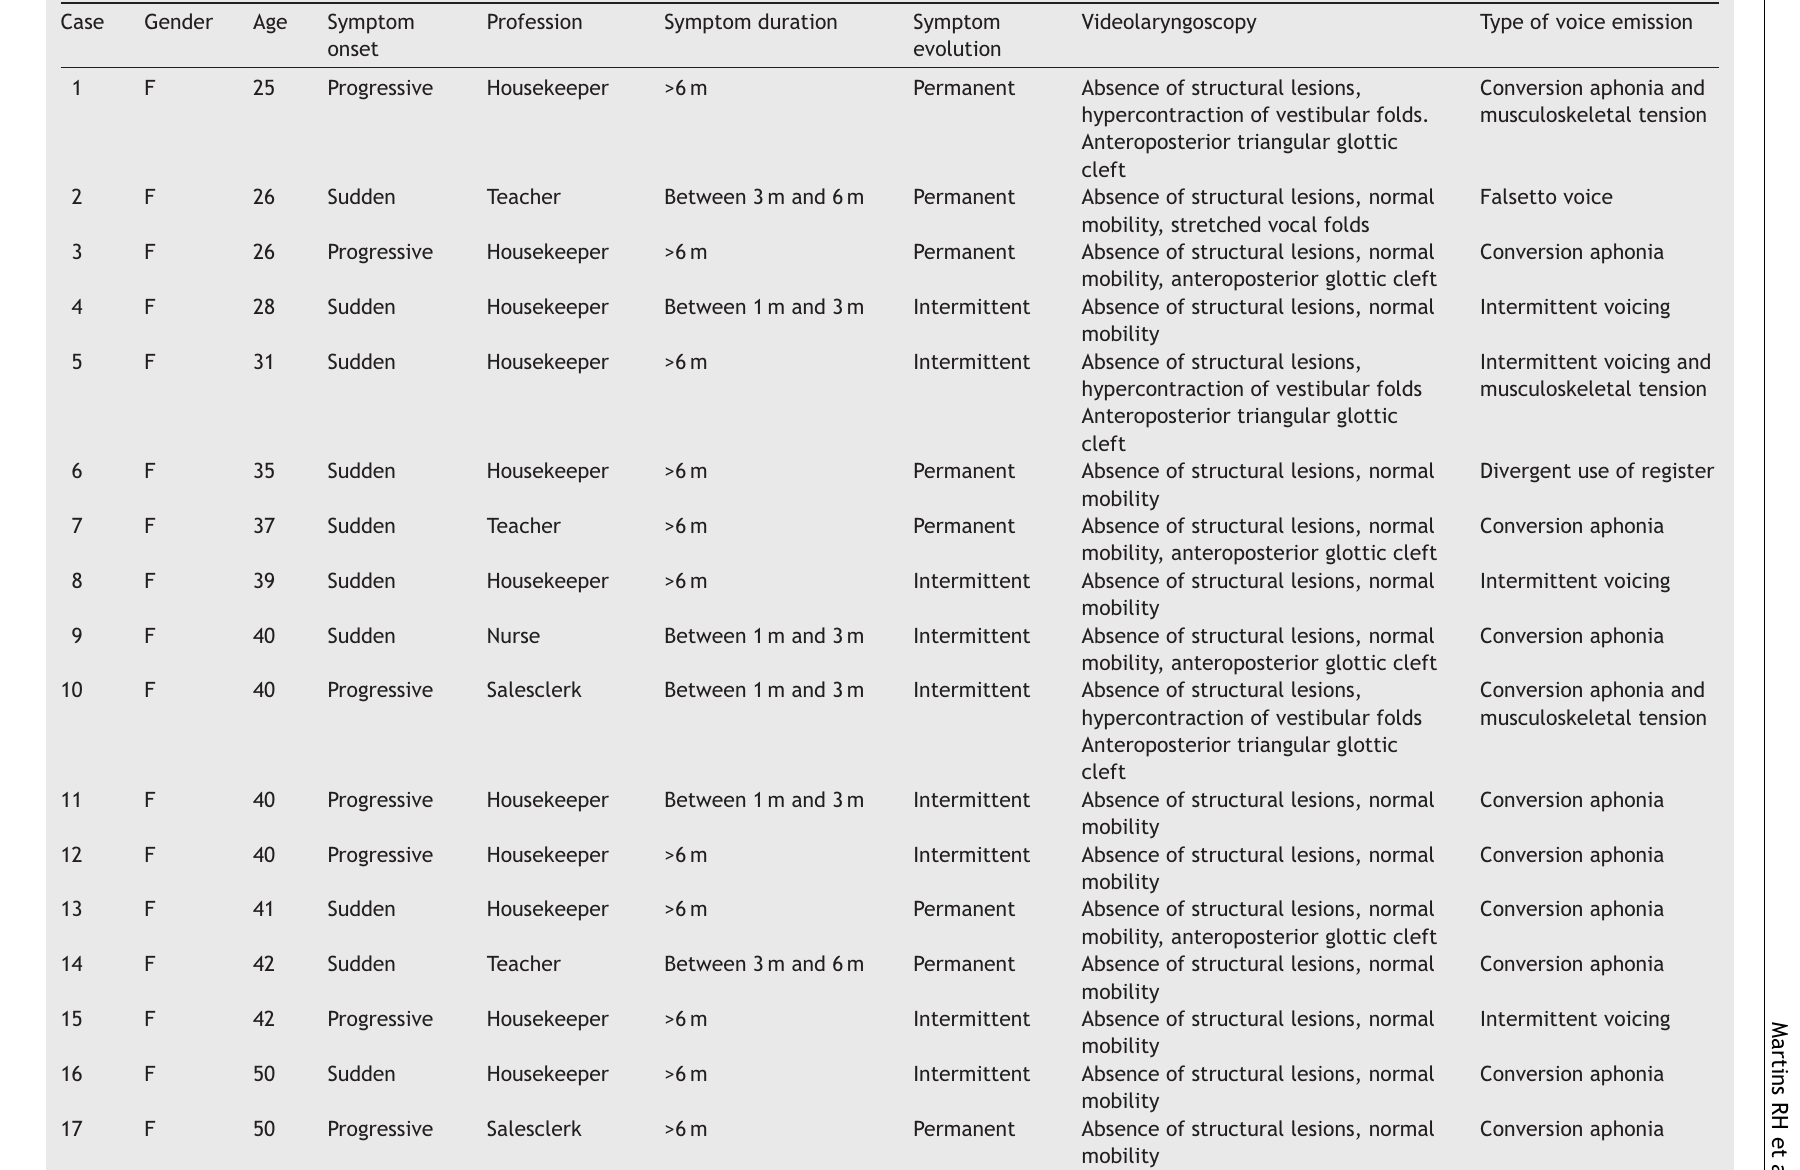
Clinical features, videolaryngoscopic findings, and type of voice emission in patients with psychogenic